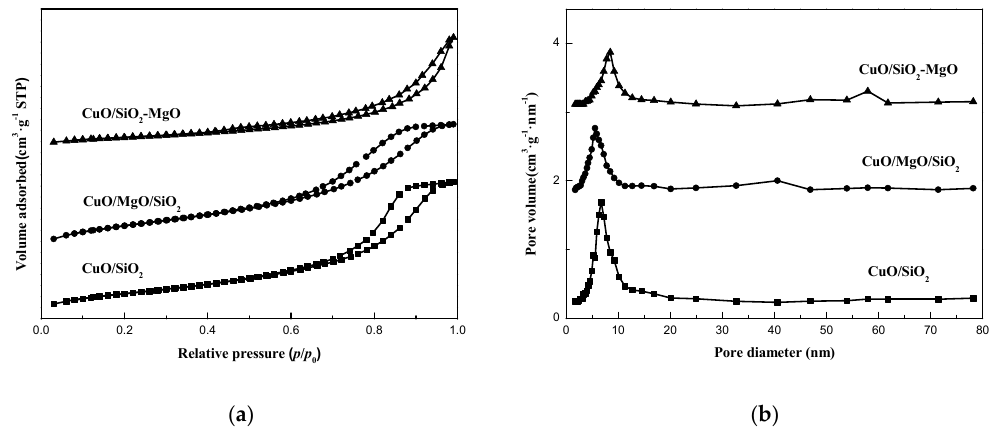
Figure 5. N 2 adsorption-desorption isotherms ( a ) and pore size distributions ( b ) of catalysts.